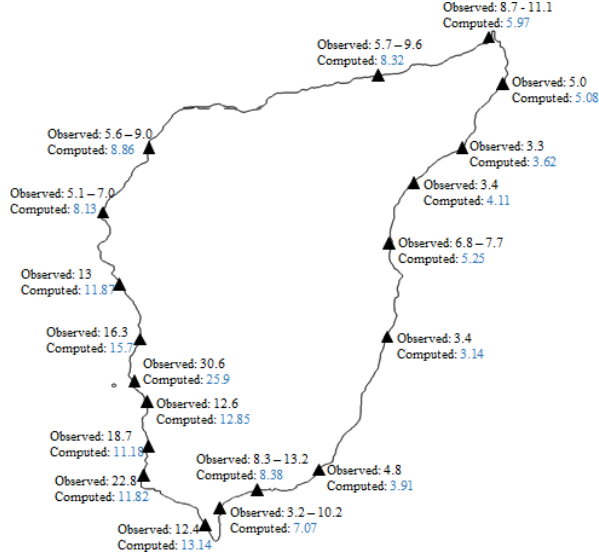
Figure 23. Computed and observed run-up values in meters along the coast of Okushiri